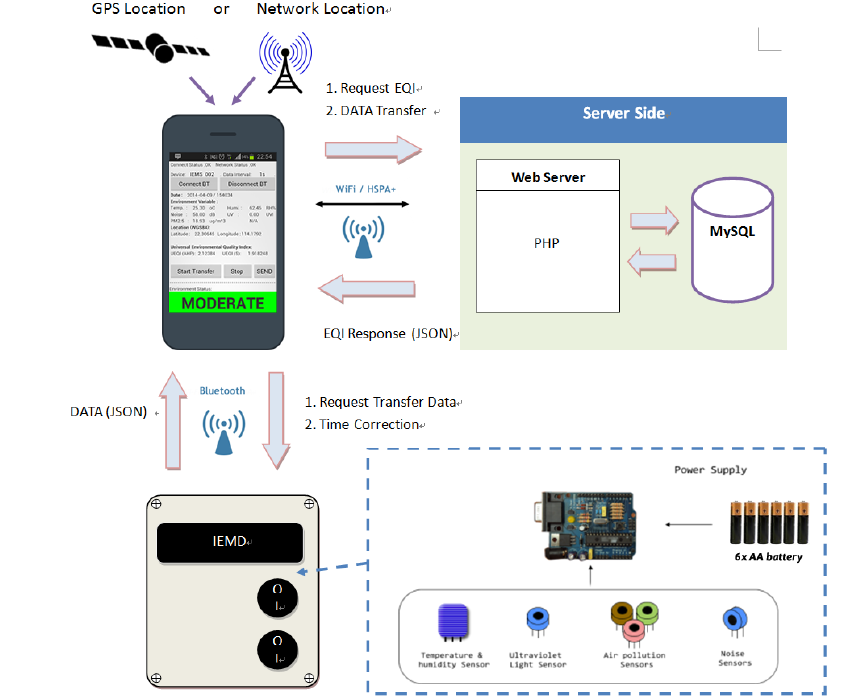
Figure 1. System overview of